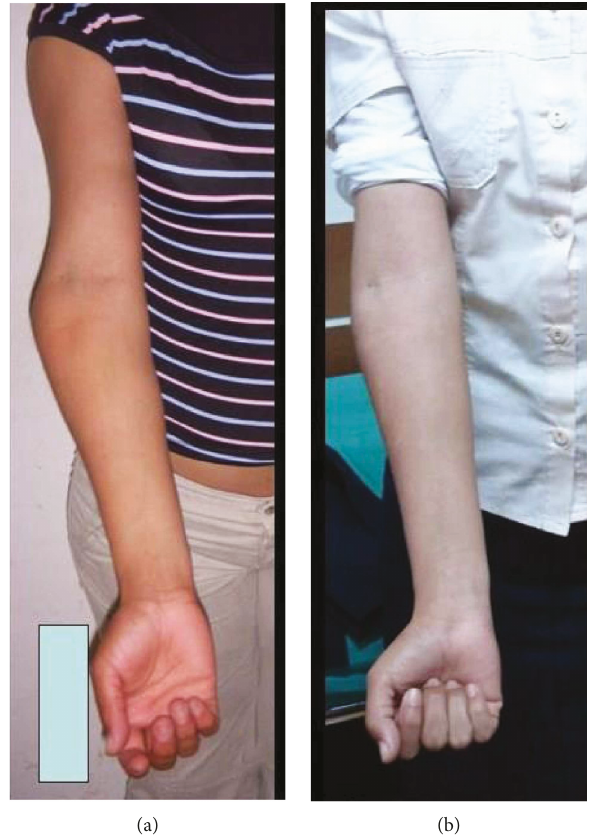
Figure 1: Case 1. Clinical appearance: (a) preoperative and (b) postoperative.